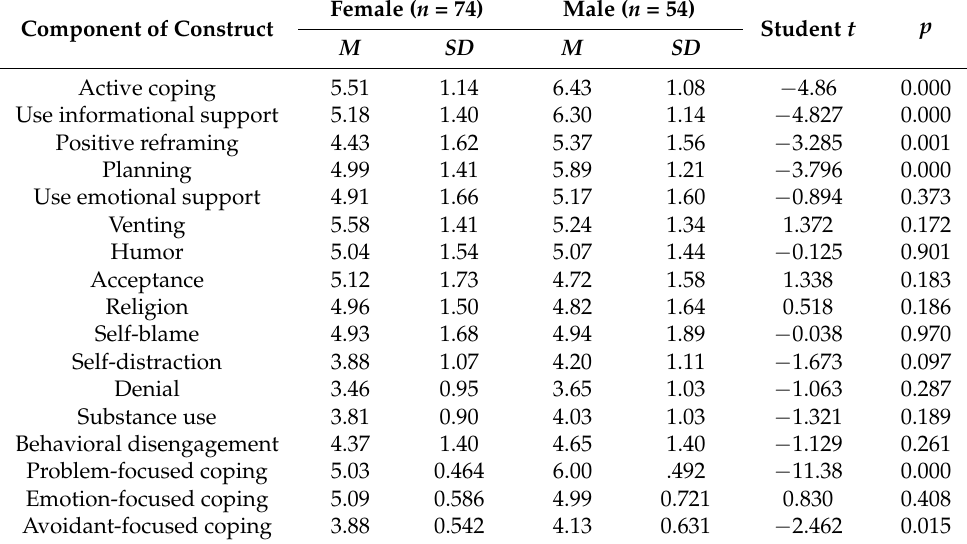
Table 2. Scores of coping construct components in terms of gender *. Female ( n = 74) Component of Construct